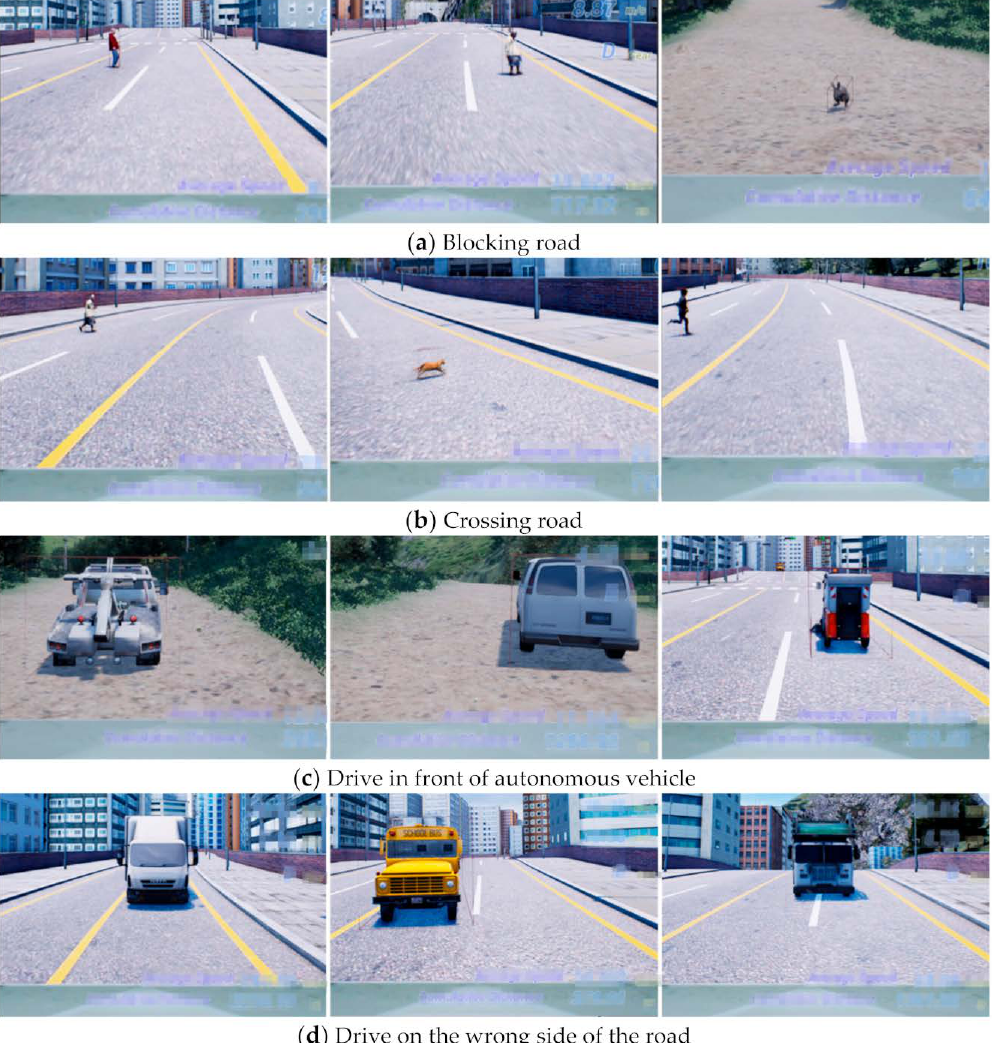
Figure 13. Scenario simulation results in the automatic event